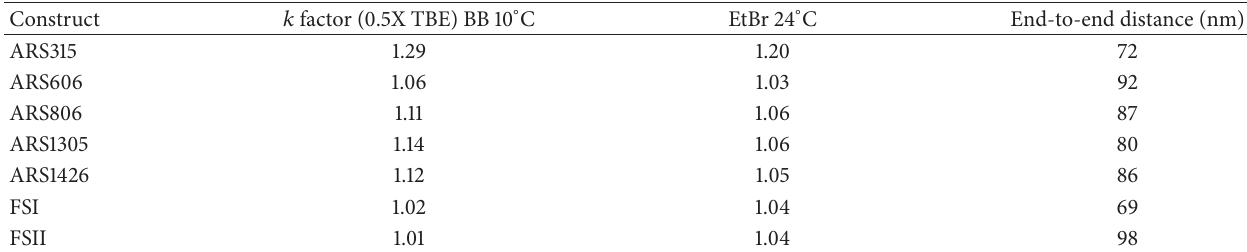
Table 8: Calculation of the 𝑘 factor from the PAGE